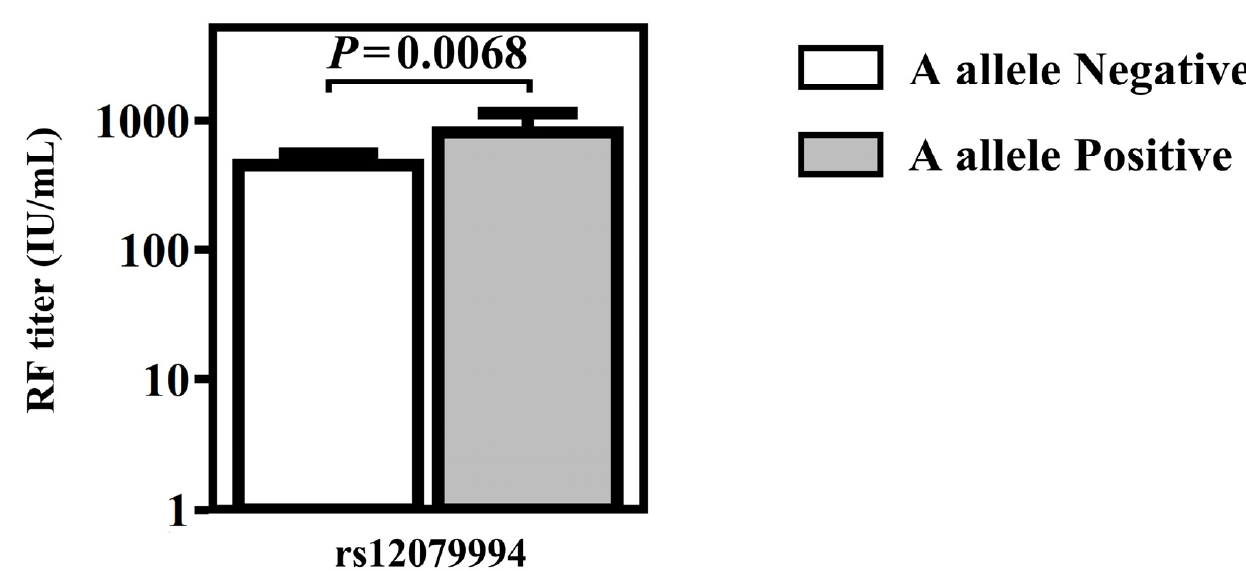
OR: odds ratio. CI: confidence interval.